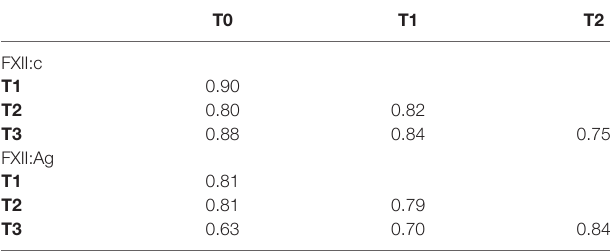
TaBle 4 | Correlations of factor XII activity and antigen over four time points in multiple sclerosis patients.